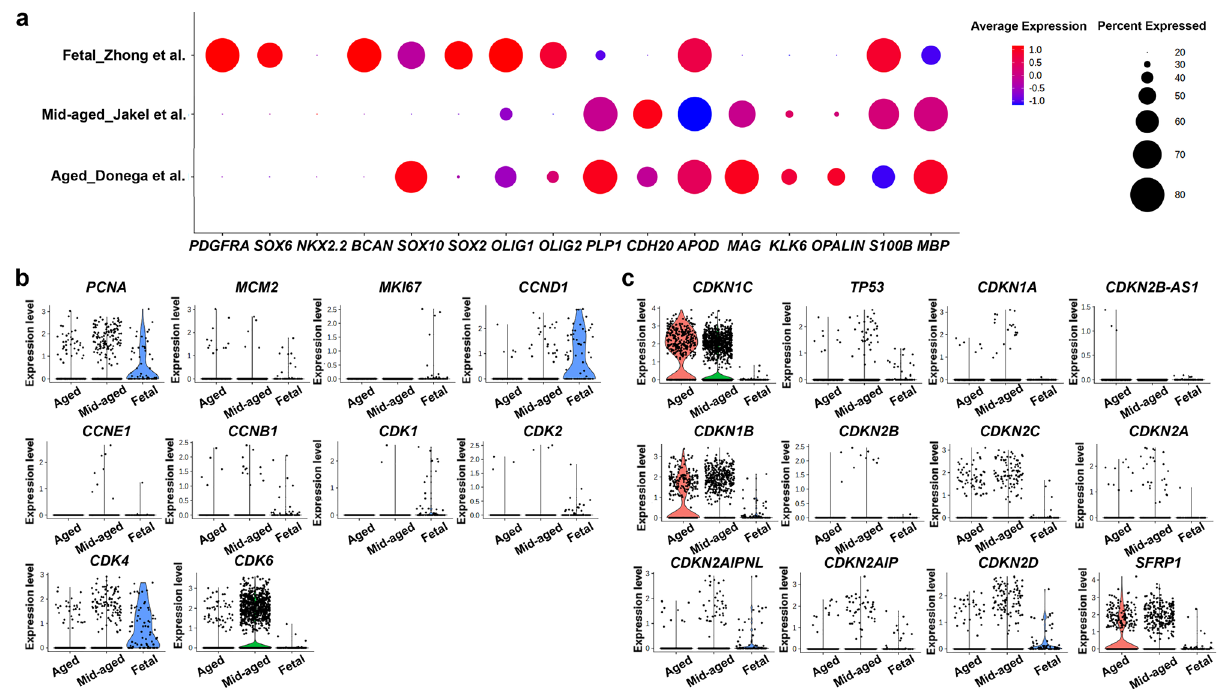
Fig. 3 Increased expression of cell cycle inhibitors in OPCs from the aged human SVZ. a Dot plot showing the expression level (red = high, blue = low) and percentage of cells expressing markers of the oligodendroglial lineage. b , c Violin plots of markers for proliferation and cell cycle progression ( b ) and of markers for quiescence and cell cycle inhibition ( c ) in cells from the OPC lineage from Zhong et al. 39 , Jäkel et al. 42 , and present study (Donega et al.). ( n = 3 donors; 2 females, aged 95 (504 cells) and 96 years (118 cells); 1 male, aged 72 years (116